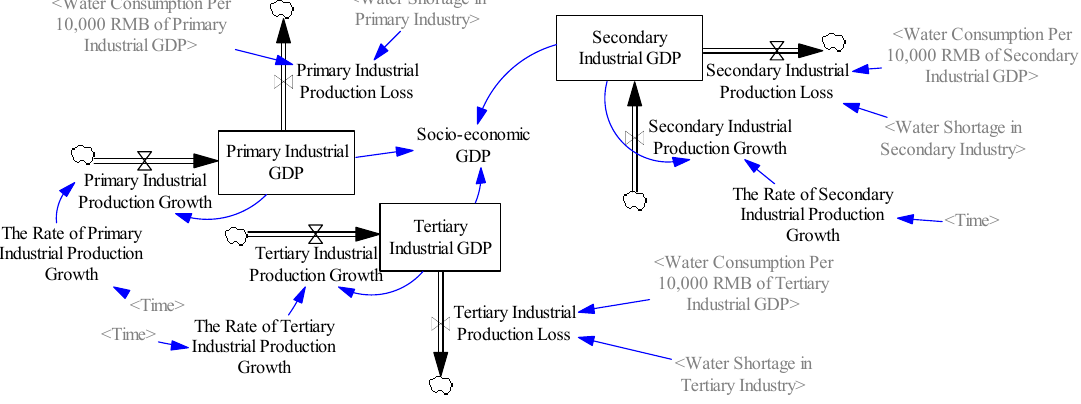
Figure 2. System dynamics flowchart of the economic subsystem.